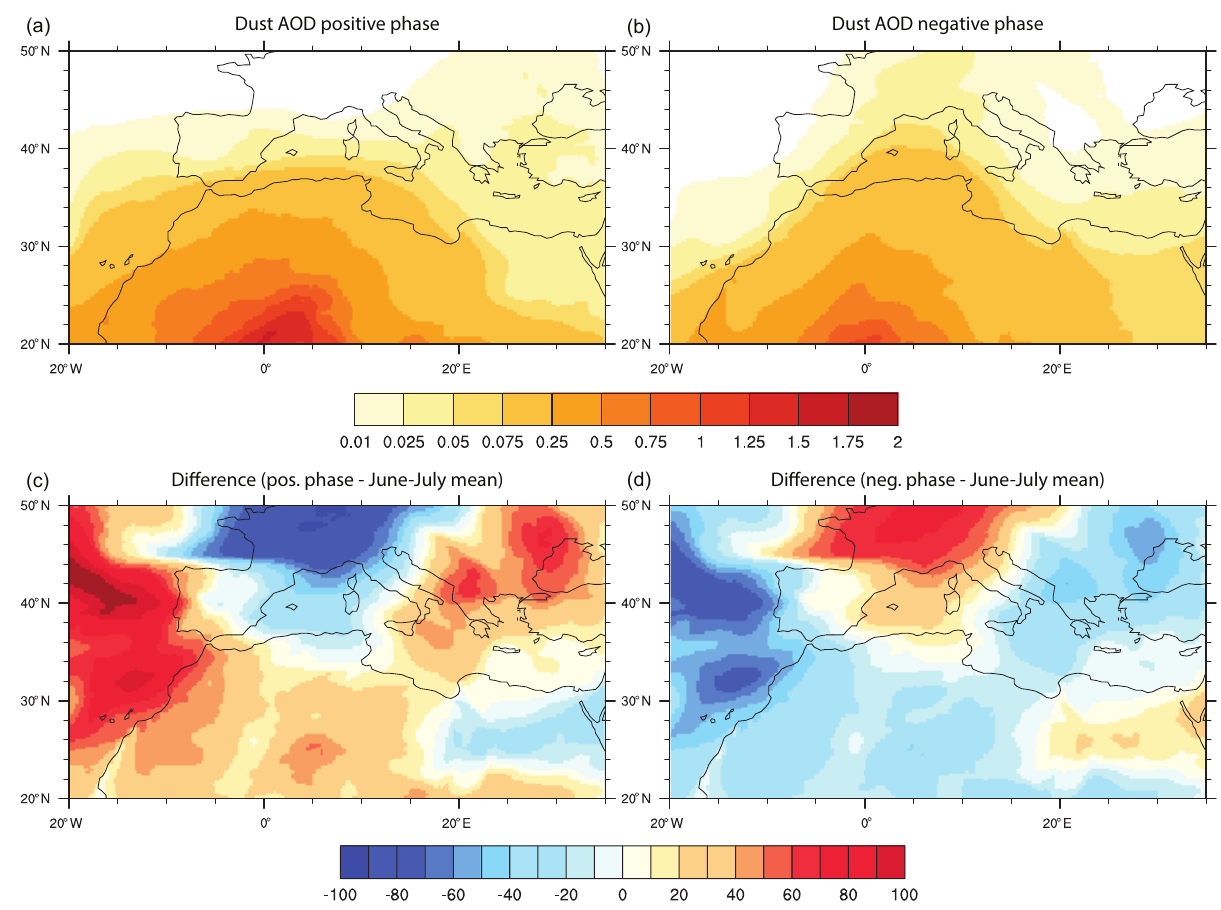
Figure 8. Composite of the dust AOD for positive (a) and negative (b) phases of the first EOF for June–July 2013. Panels (c) and (d) show the difference (%) regarding the June–July 2013